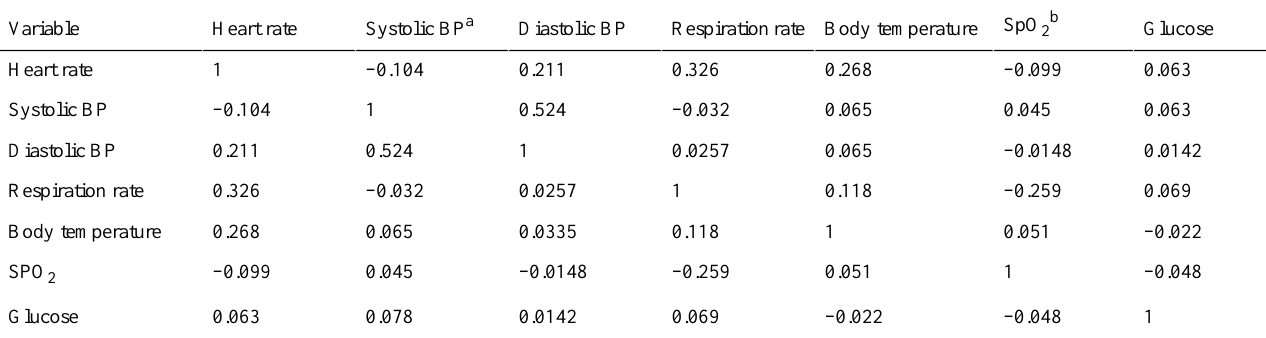
Table 3. Pearson correlation coefficients among vital signs of the baseline